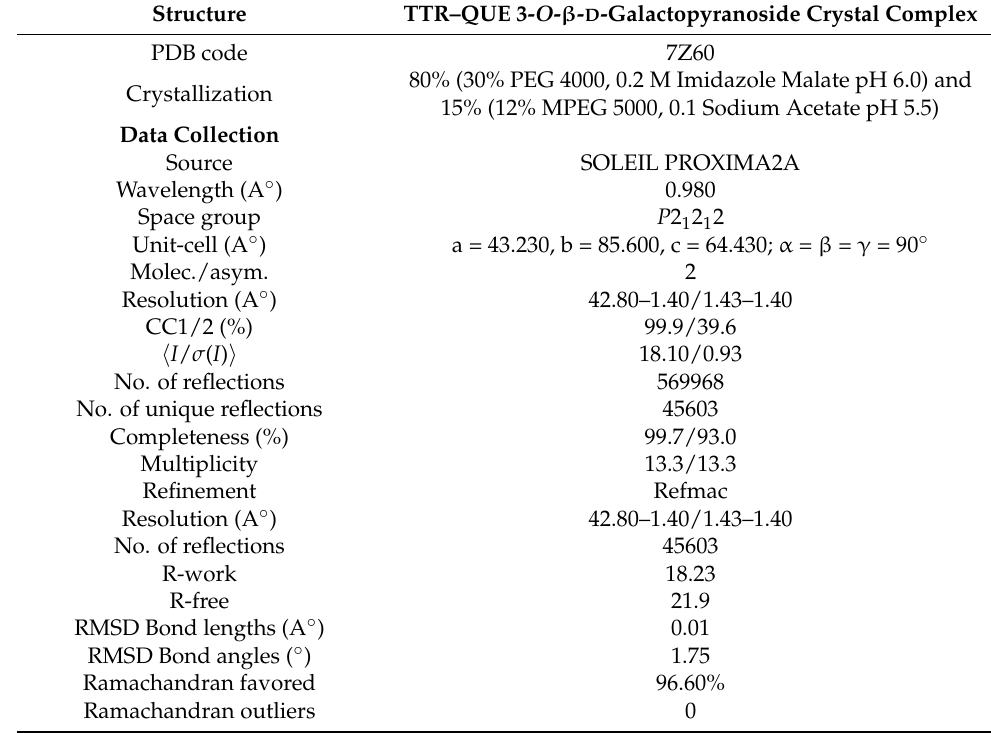
Table 1. TTR- 2 crystal complex: crystallization, data collection, processing and refinement. Structure